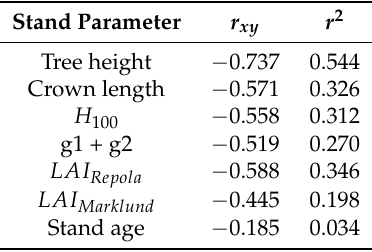
Table 2. Correlation of estimated clumping parameter and stand parameters.